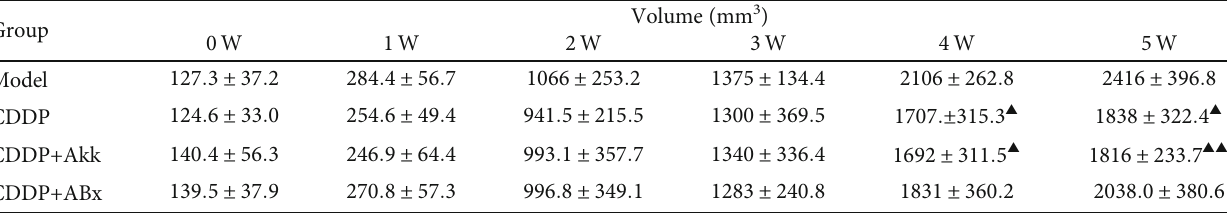
Table 2: Volume of tumor in mice ( mean ± SD , n = 10